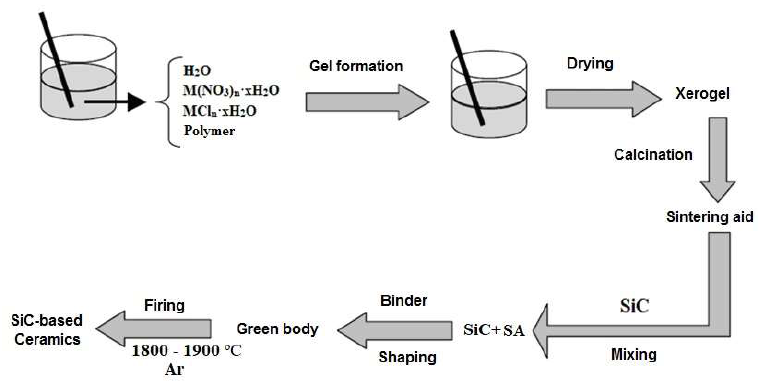
Figure 1. Xerogel formation and processing route.